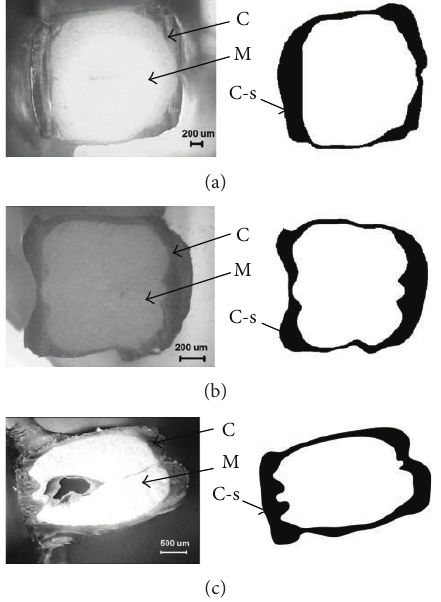
Figure 3: Flight feather shaft cross-section and scanning cross- section of the cortex. (a) Cross-section of long-eared owl feather. (b) Cross-section of pigeon feather. (c) Cross-section of golden eagle feather. C: Cortex; M: Medulla; C-s: Cross-section of the